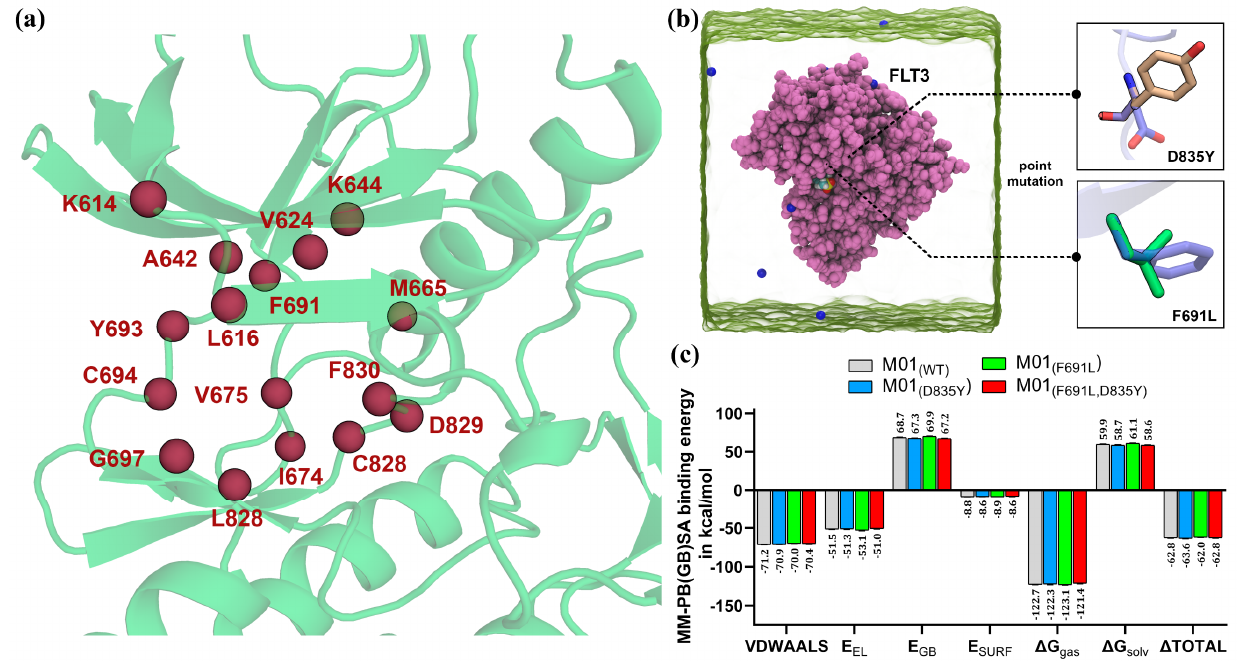
Figure 6. MM-PB(GB)SA binding free energy comparison between M01 and FLT3 variants. ( a ) Common residues that contributed to the ΔTOTAL BE to the ligands are shown in the sphere representation. ( b ) Point mutations were manually performed at D835 and F691 in Pymol to compare the MM-PB(GB)SA binding energy. ( c ) Comparison of the MM-PB(GB)SA binding energy terms between WT, D835Y, F691Y, and both (F691L, D835Y) mutant FLT3 and Table 1. MM-PB(GB)SA and LIE energy estimation of the FLT3 inhibitor complexes.